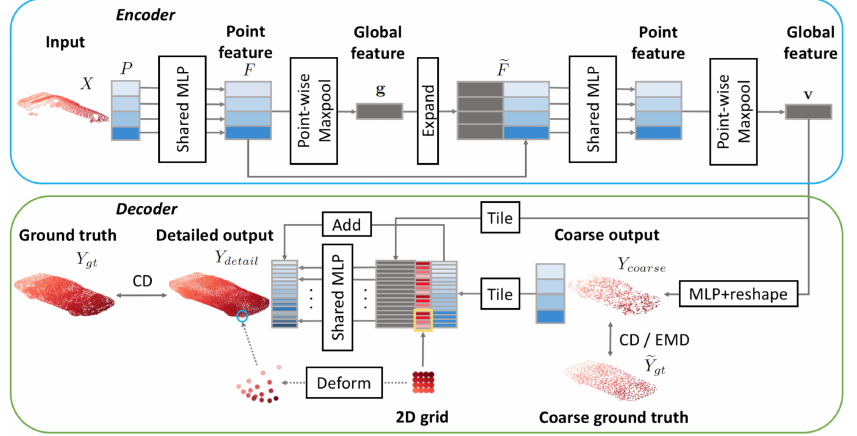
Figure 20. Point Completion Network [128]